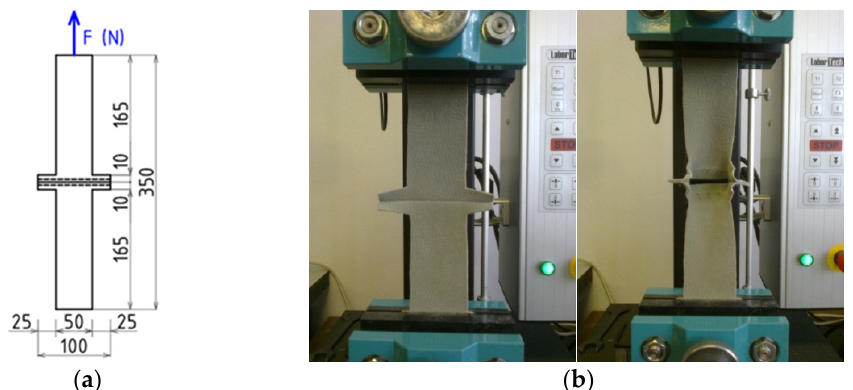
Figure 3. ( a ) the sample dimensions, ( b ) testing of the stitch.